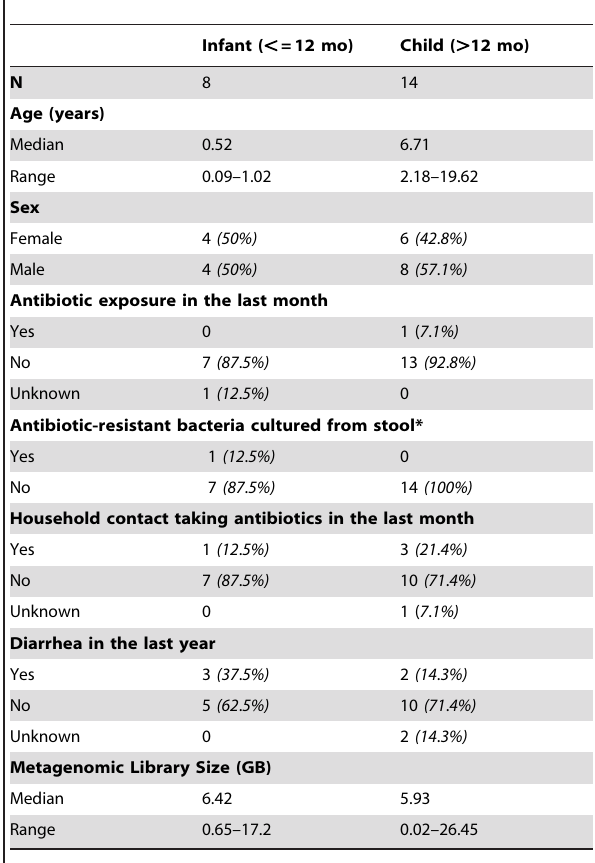
Table 1. Clinical characteristics of fecal sample